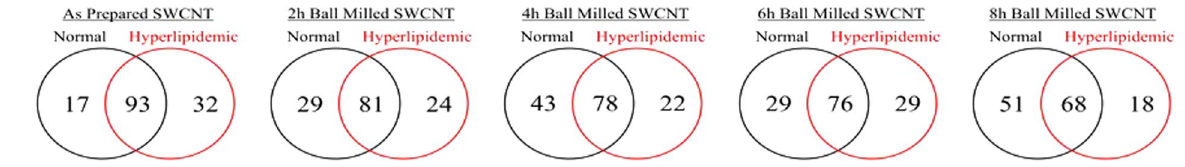
Figure 5. Venn diagrams representing the number of proteins found to associate with SWCNTs due to incubation in either normal or hyperlipidemic serum (n =